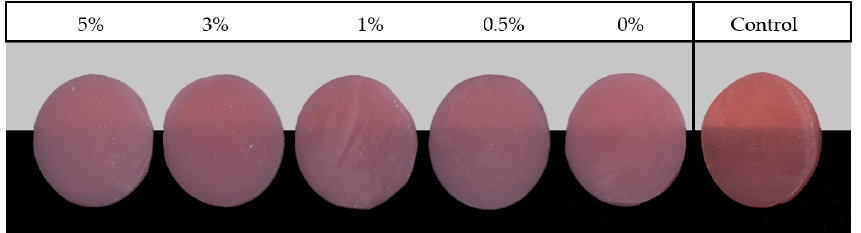
Figure 1. Representative photographs of the NextDent resin specimens ordered according to ZrO 2 NP concentration.